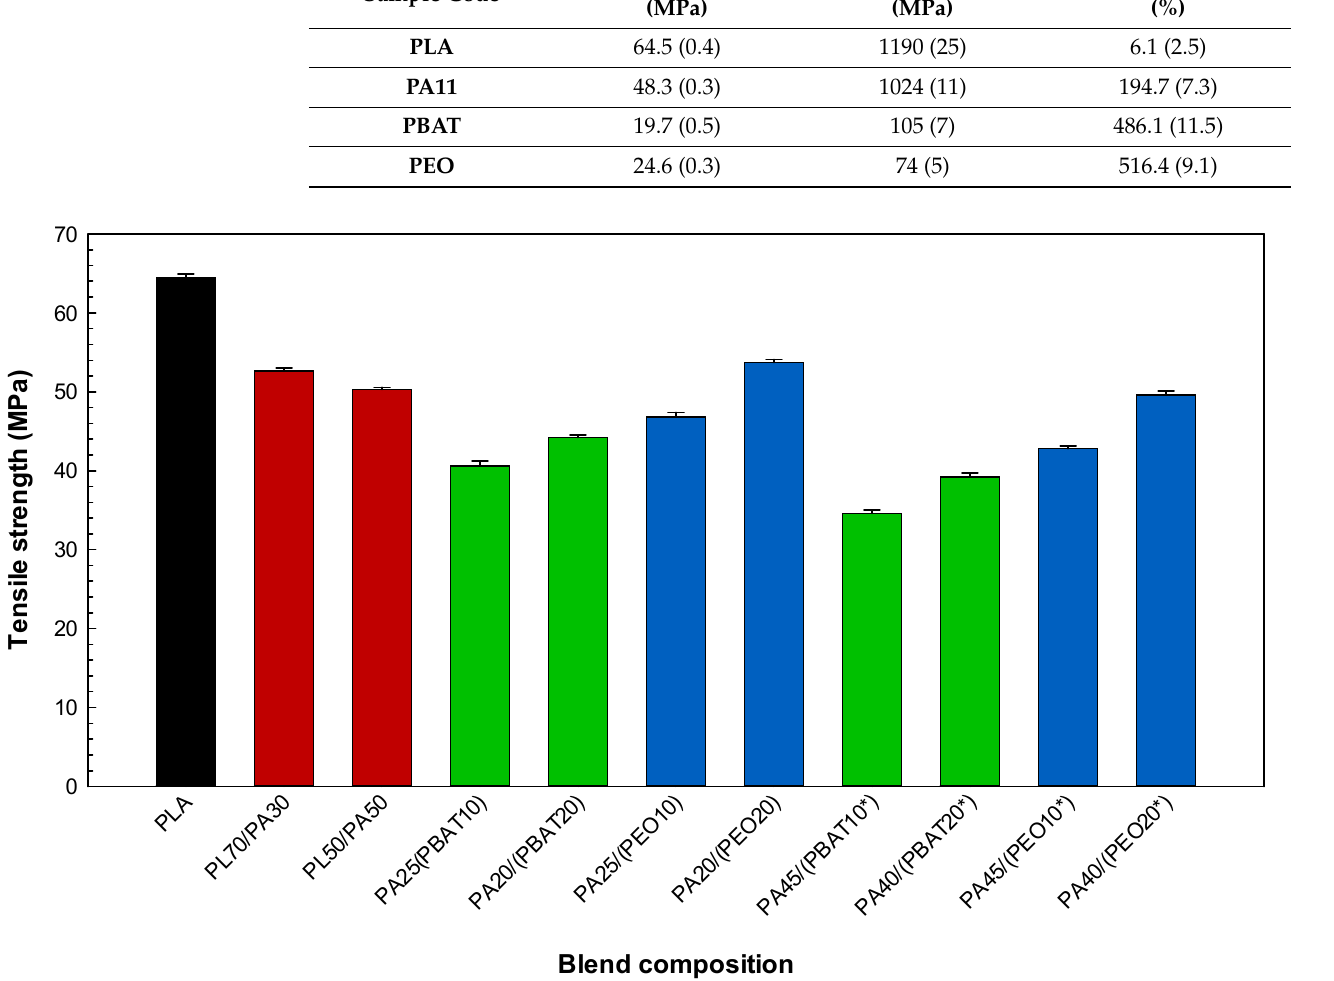
Figure 5. Tensile strength of the blends (see Section 3.2 for definition).